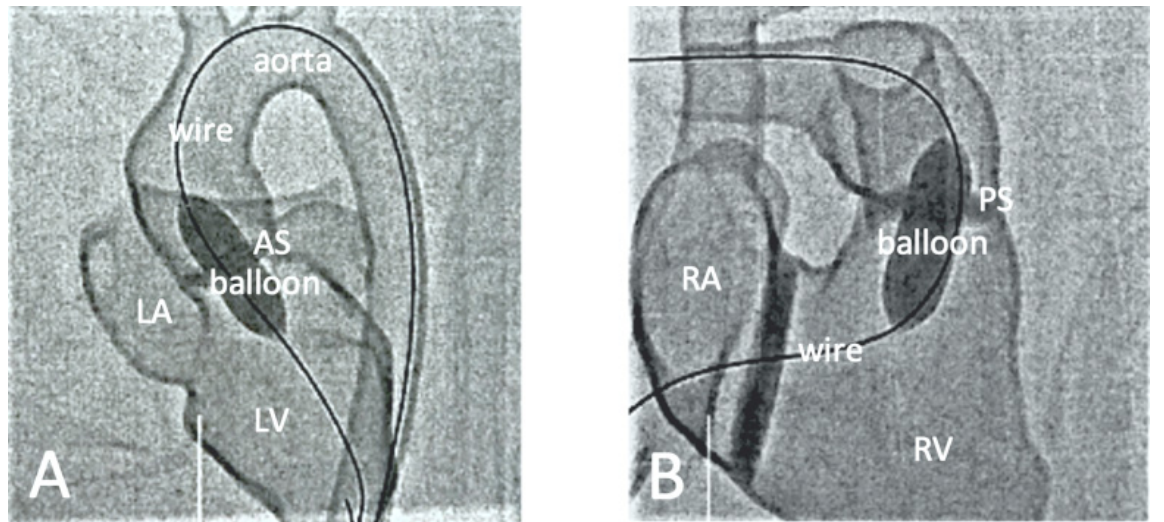
Figure 6. Fluoroscopic documentation of balloon dilatation of valvular stenosis with the 3D printed heart model. ( A ): Balloon dilatation of a valvular aortic stenosis. The inflated balloon is positioned at the level of the aortic valve. The long guidewire is inserted via the descending aorta with its tip lying in the LV. ( B ): Balloon dilatation of a valvular pulmonary stenosis. The inflated balloon is positioned at the level of the pulmonary valve. The long guide wire is inserted via the inferior vena cava through the RA into the RV, with its tip lying in the right pulmonary artery. AS-aortic stenosis, PS-pulmonary stenosis, LA-left atrium, LV-left ventricle, RA-right atrium, RV-right ventricle. Reprinted with permission under the open access from Brunner et al.